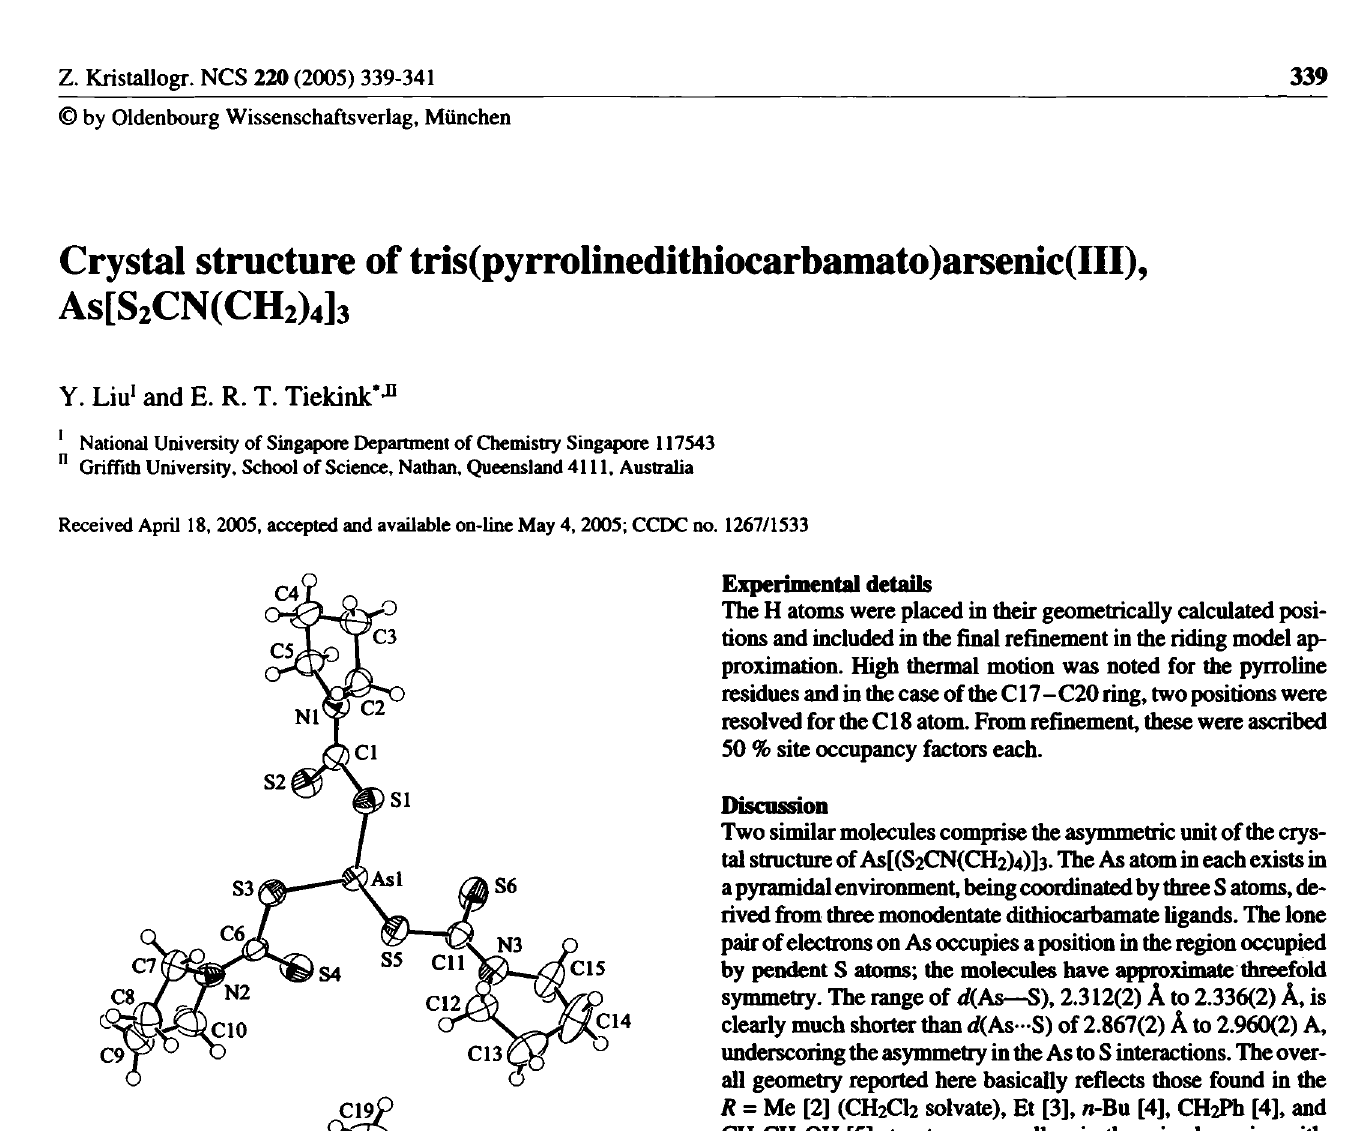
Table 1. Data collection and handling.